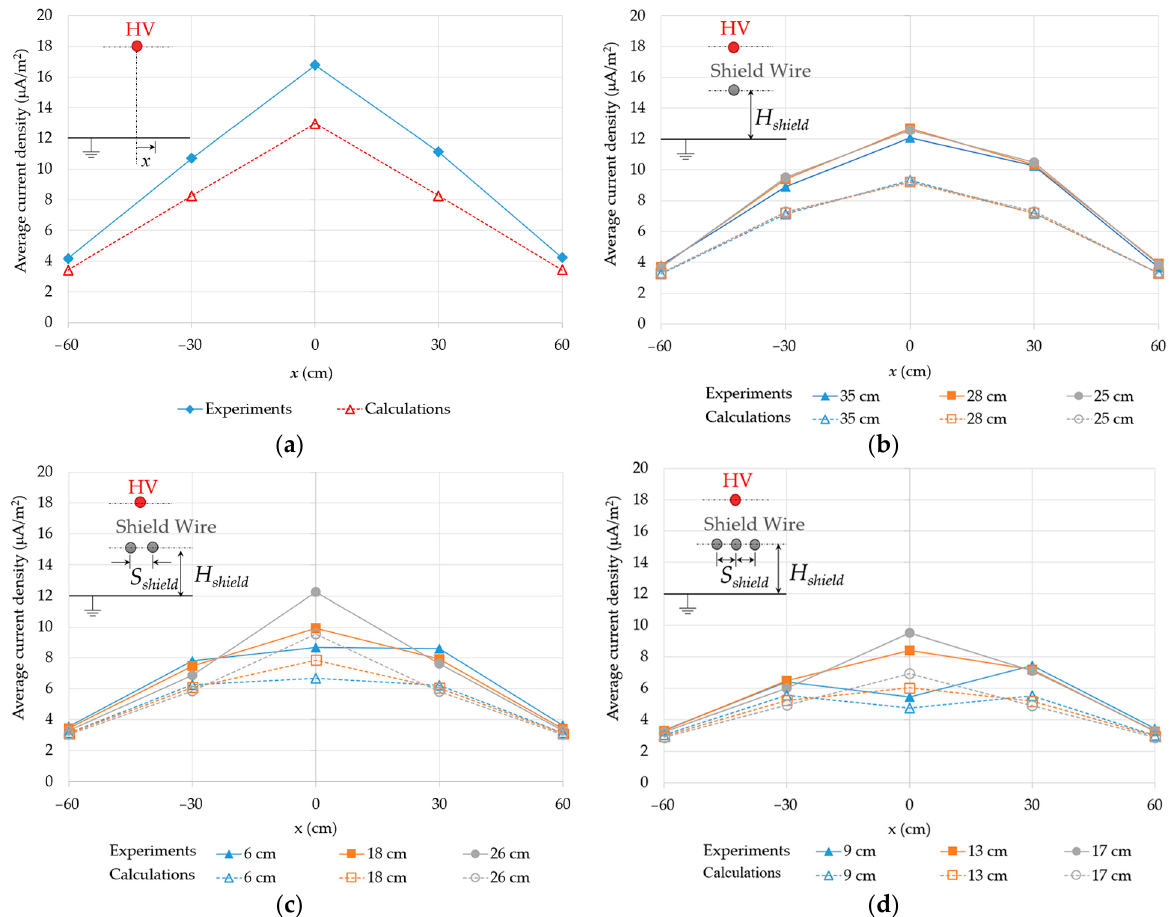
Figure 6. Comparison between the experimental and calculated average current density of the reduced scale configuration: ( a ) no shield wire; ( b ) one shield wire at H shield = 25, 28 and 35 cm; ( c ) two shield wires at S shield = 6, 18 and 26 cm; ( d ) three shield wires at S shield = 9, 13 and 17 cm.